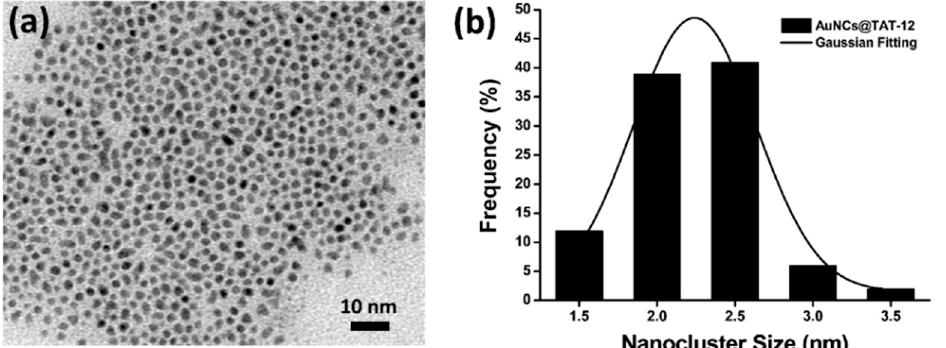
Figure 6. ( a ) TEM image of AuNCs@TAT-12 and ( b ) a histogram of nanocluster size distribution of AuNCs@TAT-12 and its Gaussian fitting curve.